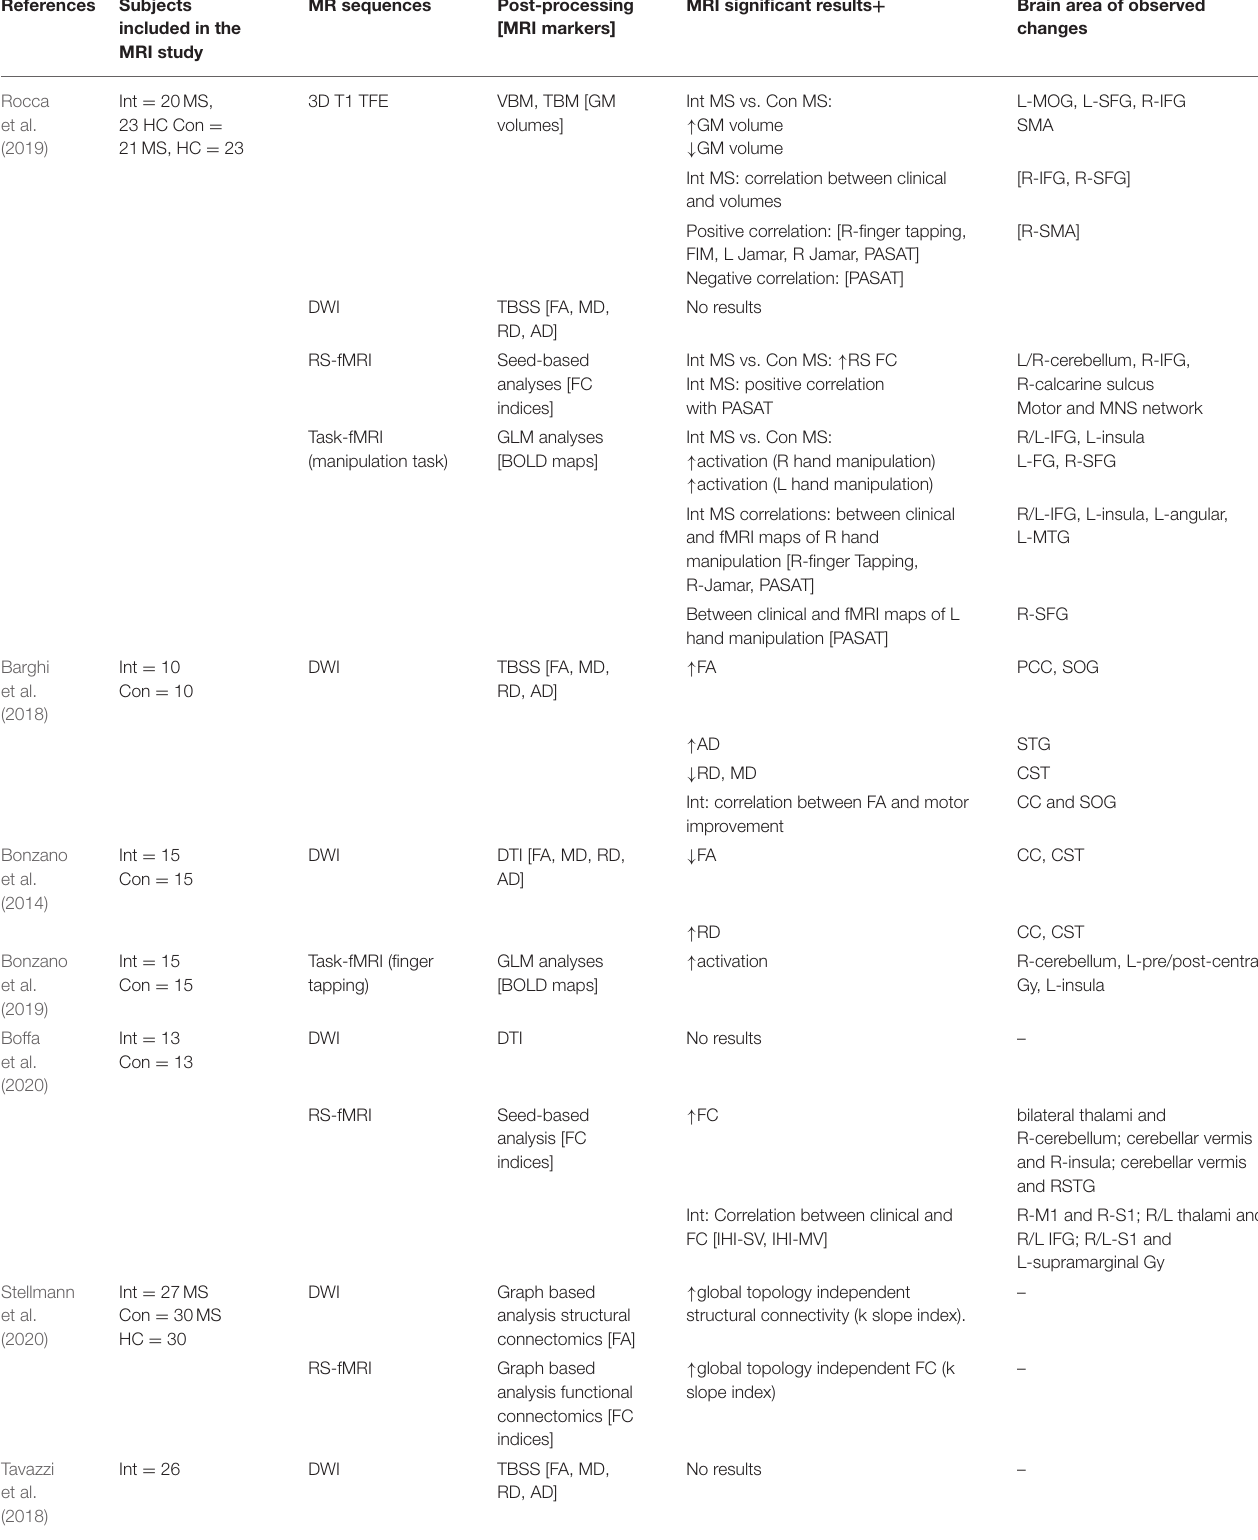
TABLE 2 | MRI characteristic of the studies and significant results. References Subjects included in